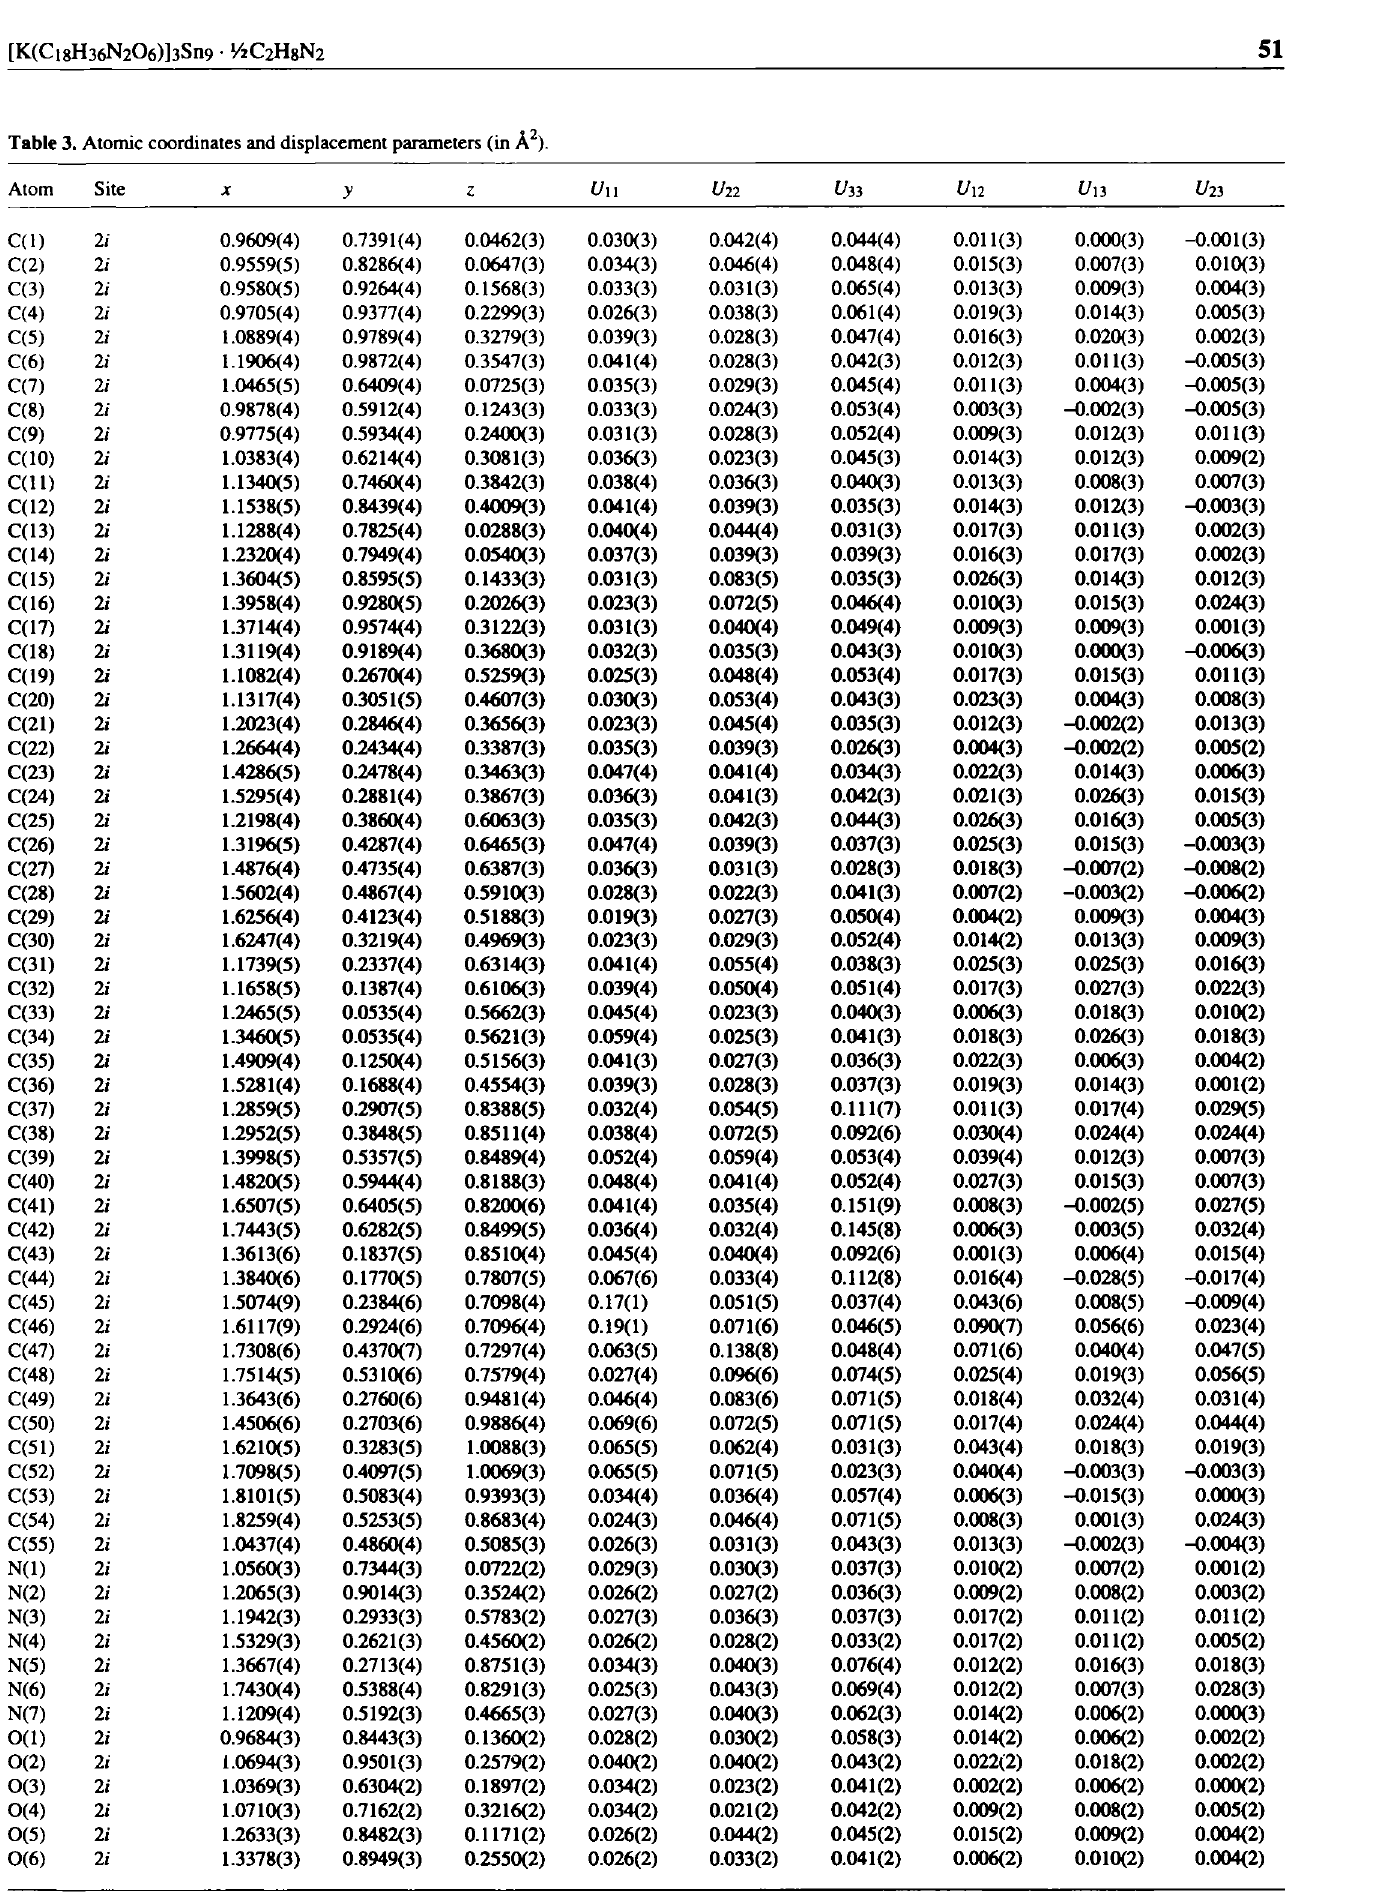
Table 3. Atomic coordinates and displacement parameters (in Ä 2